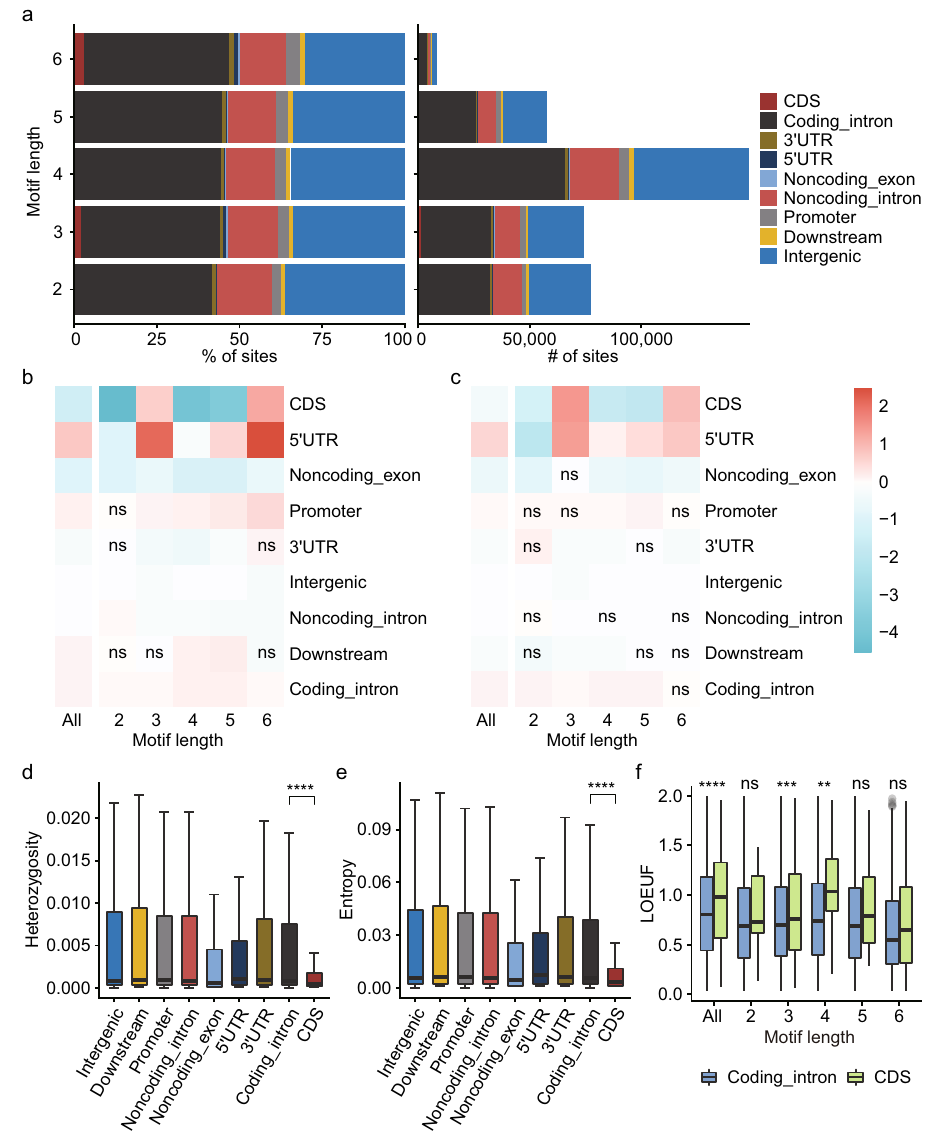
Fig.3|pSTRfunctionalproperties.a FunctionalconsequenceforpSTRsstrati fi ed by motif length: (left) cumulative proportion and (right) cumulative number. Coding_intron, introns of protein-coding genes; Noncoding_exon, exons of non- coding genes; Noncoding_intron, introns of noncoding genes. b Log2-fold enrich- ment of the pSTR call set compared against the pSTRs permutated. c Log2-fold enrichment of the mSTR call set compared against the mSTRs permutated. For both Fig. b and c , a permutation test was repeated 1000 times, and empirical P values were computed together with the enrichment values by GAT v1.3.4 and adjusted using Benjamini – Hochberg method. ns, not signi fi cant (adjusted P value